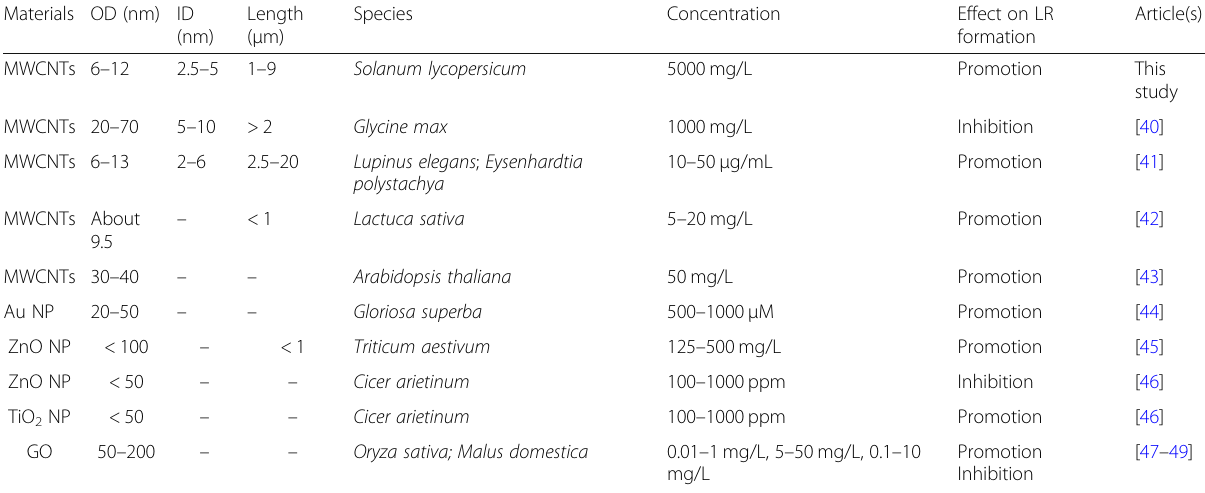
Table 1 Different responses in LR formation triggered by nanomaterials Materials OD (nm) ID